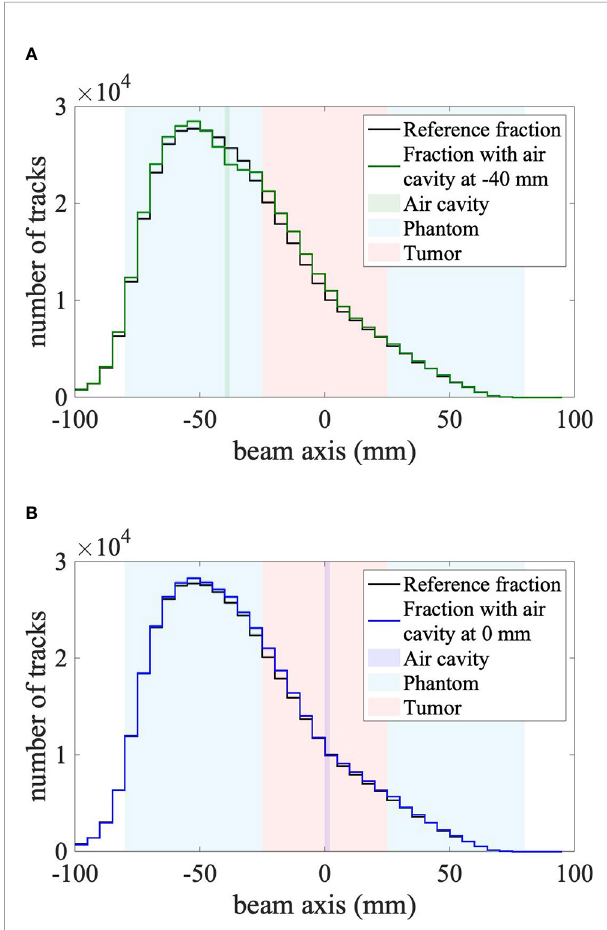
FIGURE 4 | (A) Air cavity at -40 mm (in front of the tumor). (B) Air cavity at 0 mm (center of the tumor). Secondary-ion emission pro fi les measured by the mini-tracker placed at an angle of 50° and a distance of 12 cm from the center of the target. The irradiation fraction with a cavity in front of the tumor volume (solid green line) is plotted on the left, whereas the irradiation fraction with a cavity in the middle of the tumor volume (solid blue line) is plotted on the right. The solid black line in both plots represents the reference fraction. Corresponding statistical uncertainties are plotted as uncertainty bands for each pro fi le, which are smaller than the line width. The head phantom is centered at 0 mm and is represented by the blue area, the 25-mm-radius tumor volume is represented by the red area and the inserted air cavity is represented by the vertical green and blue band in (A, B) ,